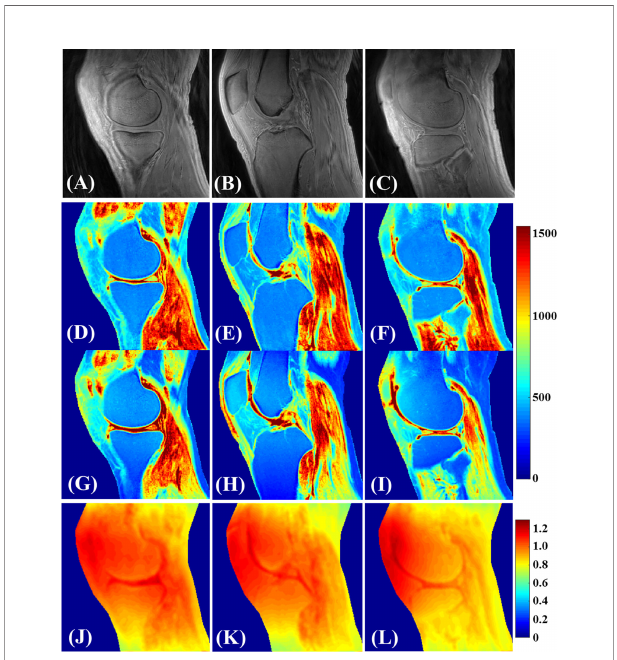
FIGURE 7 | Knee tissues in a healthy 35-year-old male volunteer (A – L) . (A – C) are the selected VFA images with FA=5°. T 1 mapping utilizing both the proposed 3D UTE-Cones AFI-VFA (D – F) and B1-uncorrected VFA (G – I) methods are illustrated. The B 1 maps generated by the AFI technique (J – L) are also depicted. T 1 estimation errors as a result of B 1 inhomogeneity in the images of (G – I) have been corrected by the proposed 3D UTE-Cones AFI-VFA technique, purticularly in areas close to the coil boundary. Modi fi ed, with permission from Ref